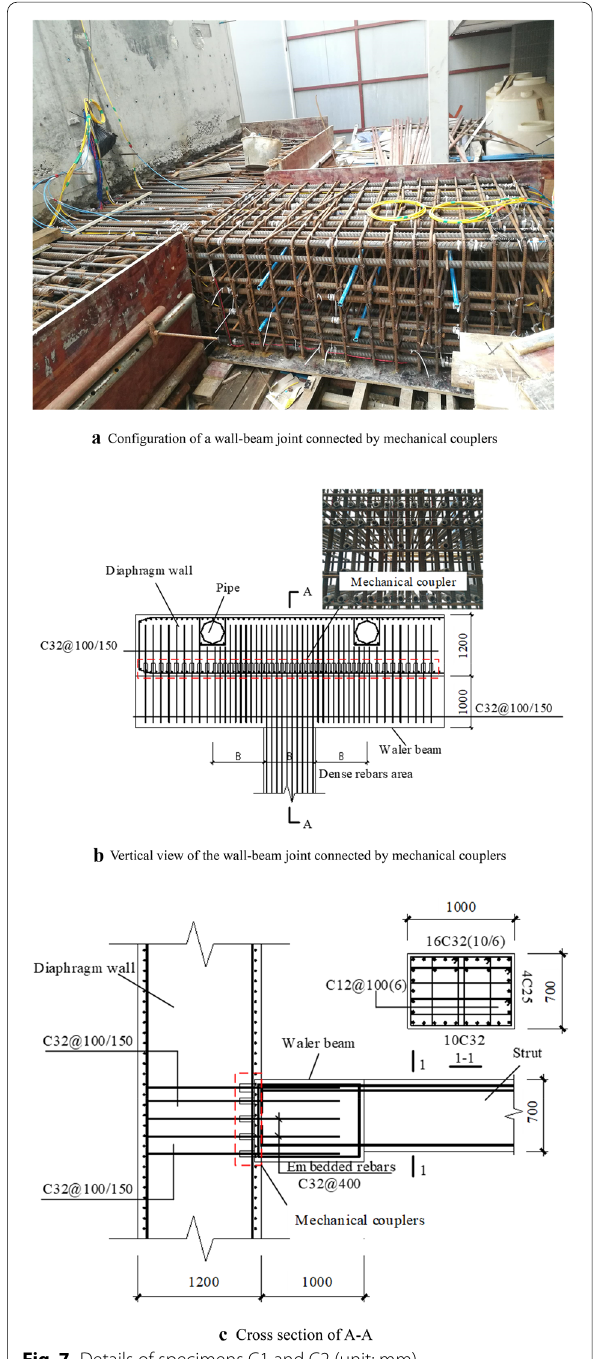
Fig. 7 Details of specimens C1 and C2 (unit: the deformation. LVDTs #1 to #4 were used to meas- ure the deformation of the strut, in which LVDT #1 was installed to calculate the vertical displacement of the loading point. LVDTs #5 and #6 were installed to record